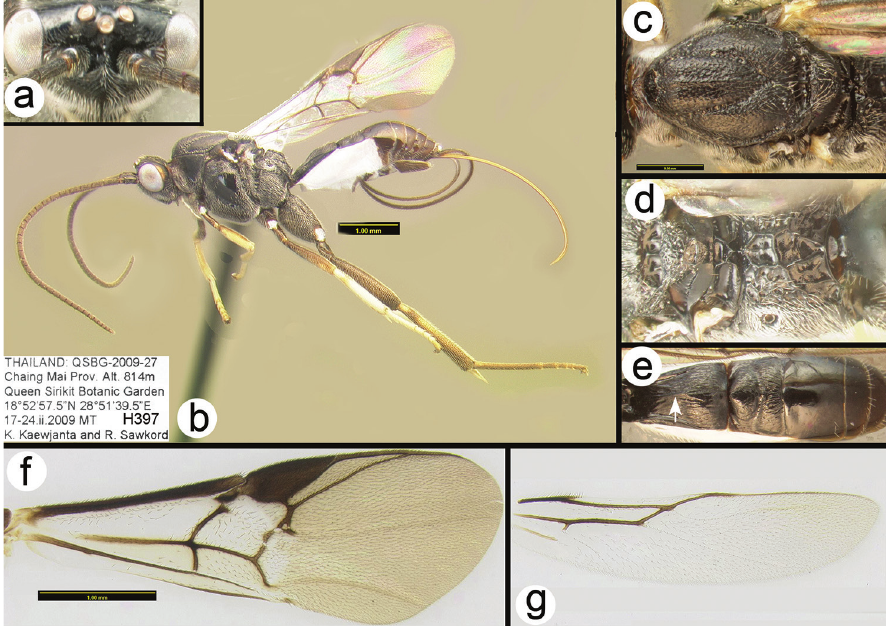
Figure 12. Liragathis damnai paratype female: a dorsal head b lateral habitus b hind tibia and tarsus c dorsal thorax d scutellum and propodeum e metasomal terga 1-3 f fore wing g hind